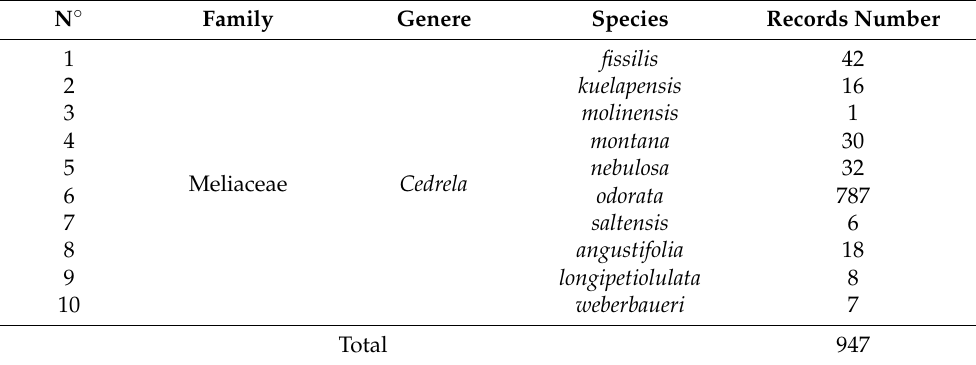
Table 1. The number of records of 10 species of the genus Cedrela used in biogeographic modeling. N ◦ Family Genere